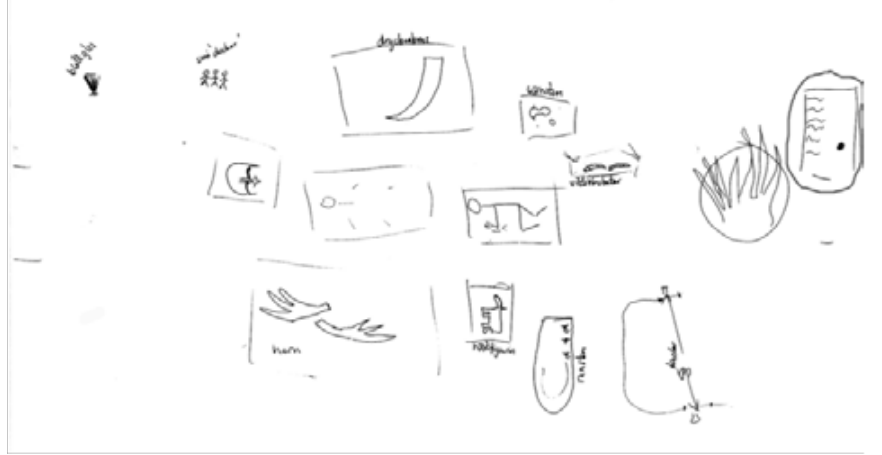
Fig 2. Text panel with transponder in the upper right corner (circling made by the